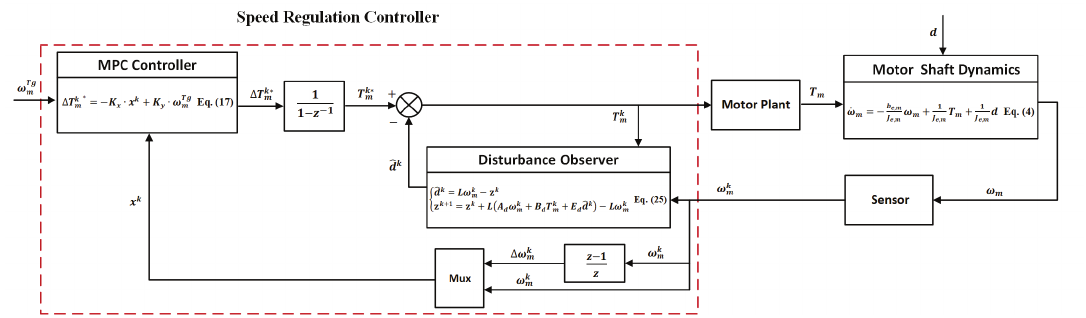
Figure 5. Block diagram of the combined speed regulation